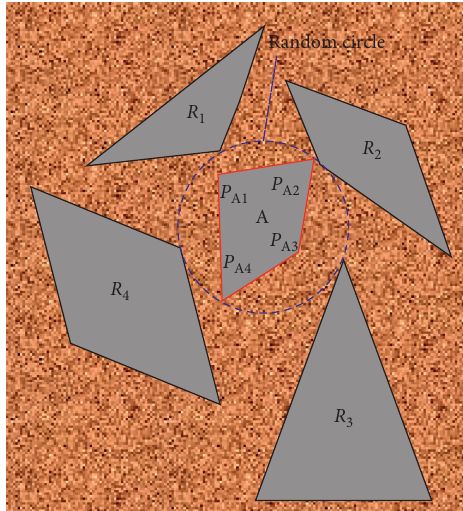
Figure 5: Established rocks in Liu’s method [4].